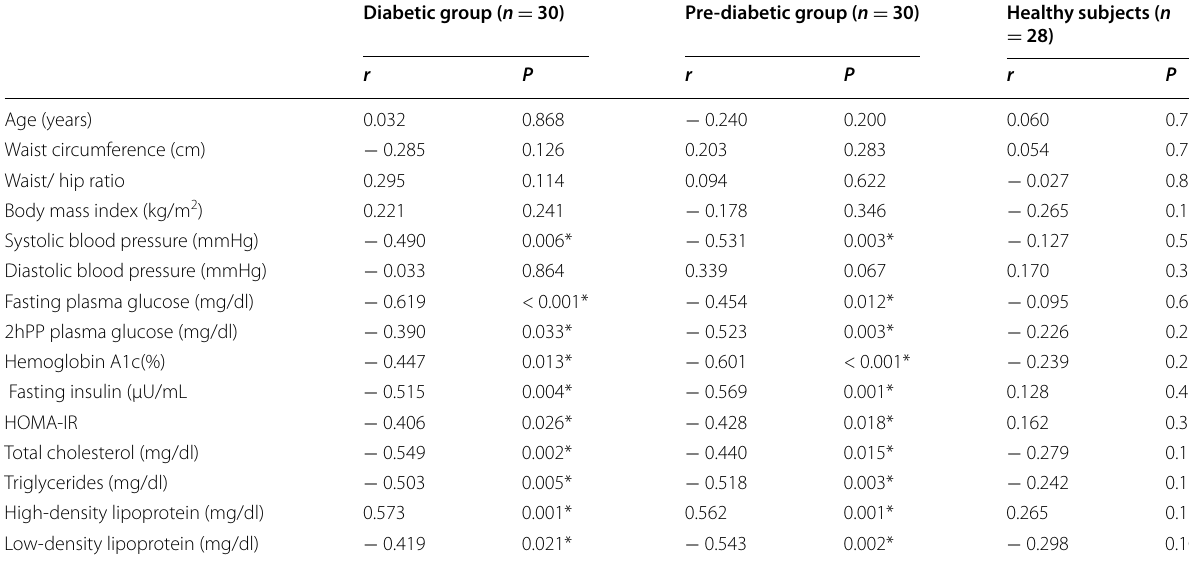
Table 2 Correlations of serum nesfatin‑1 with clinical and biochemical parameters among studied patients groups and healthy